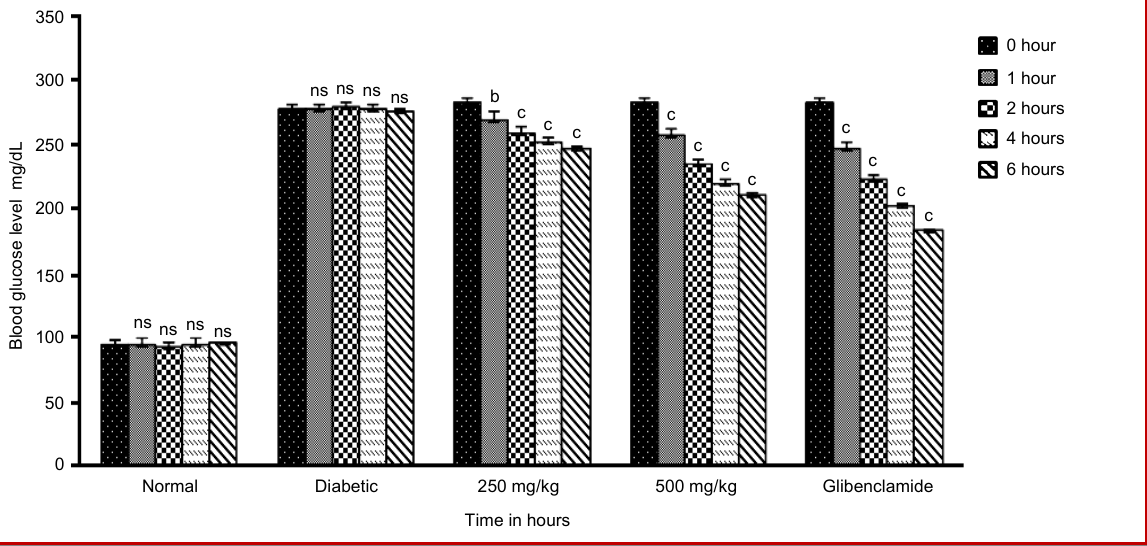
Figure 2: Hypoglycemic effect of crud powder of Teucrium stocksianum in diabetic rabbits. (n = 6) where, ns = Non-significant change; b p<0.01; c p<0.001 as compared to 0